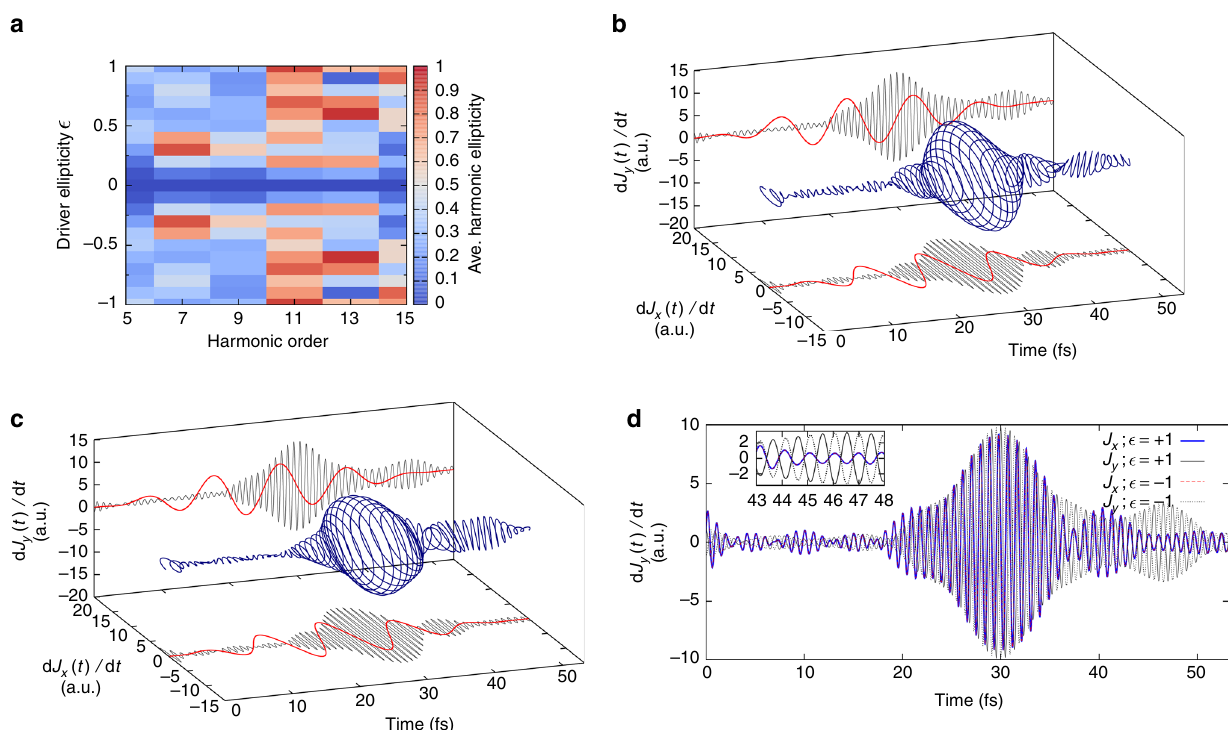
Fig. 7 Ellipticity of the emitted harmonics for bulk silicon. a Same as Fig. 6a but for bulk silicon. b , c Evolution of the time-derivative of the electronic current, bandpass fi ltered around the 11th harmonic for left-handed ( b ) and right-handed ( c ) circular polarization ( ϵ = ± 1). d Comparison of the left-handed and right-handed driven 11th harmonic. The x -component is found to be identical for the two cases, whereas the y - components have opposite phase, showing that they have fl ipped